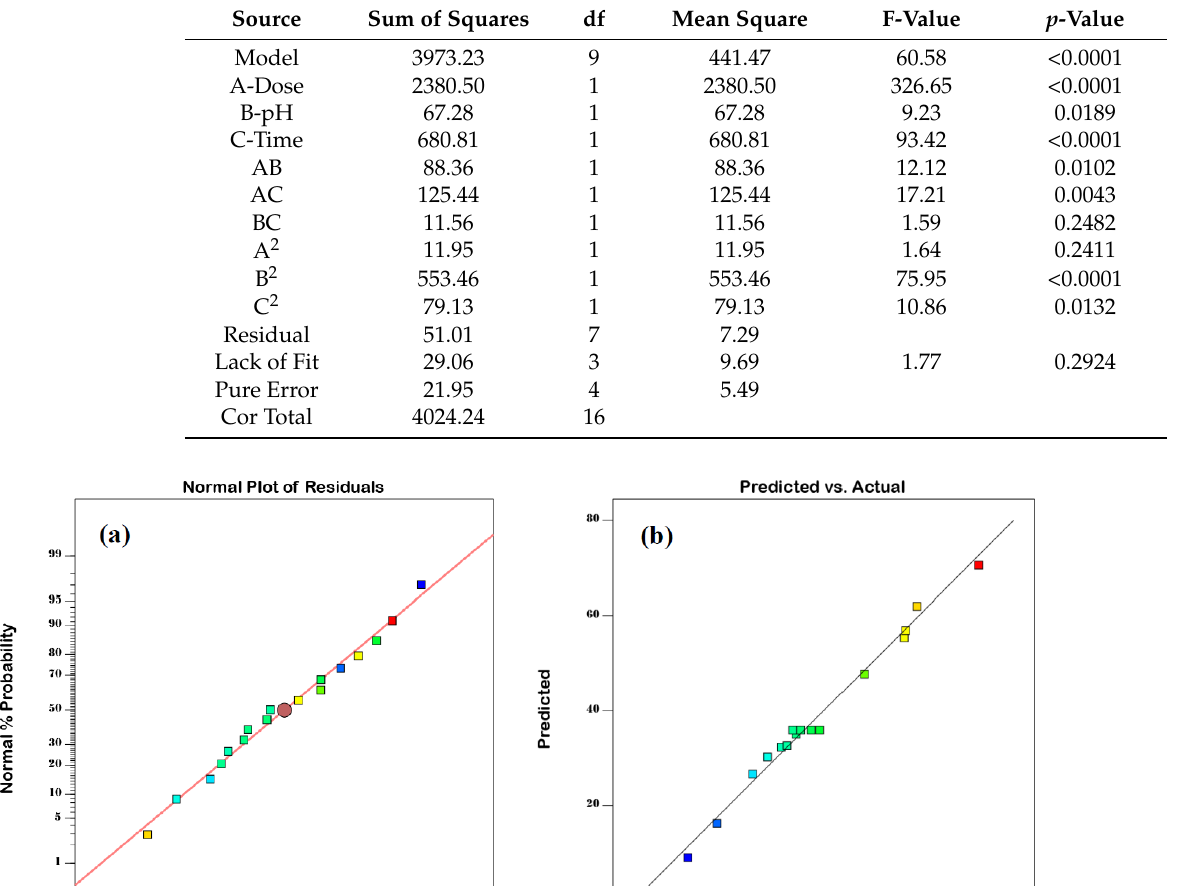
Table 5. Analysis of variance (ANOVA) for MV 2B removal.